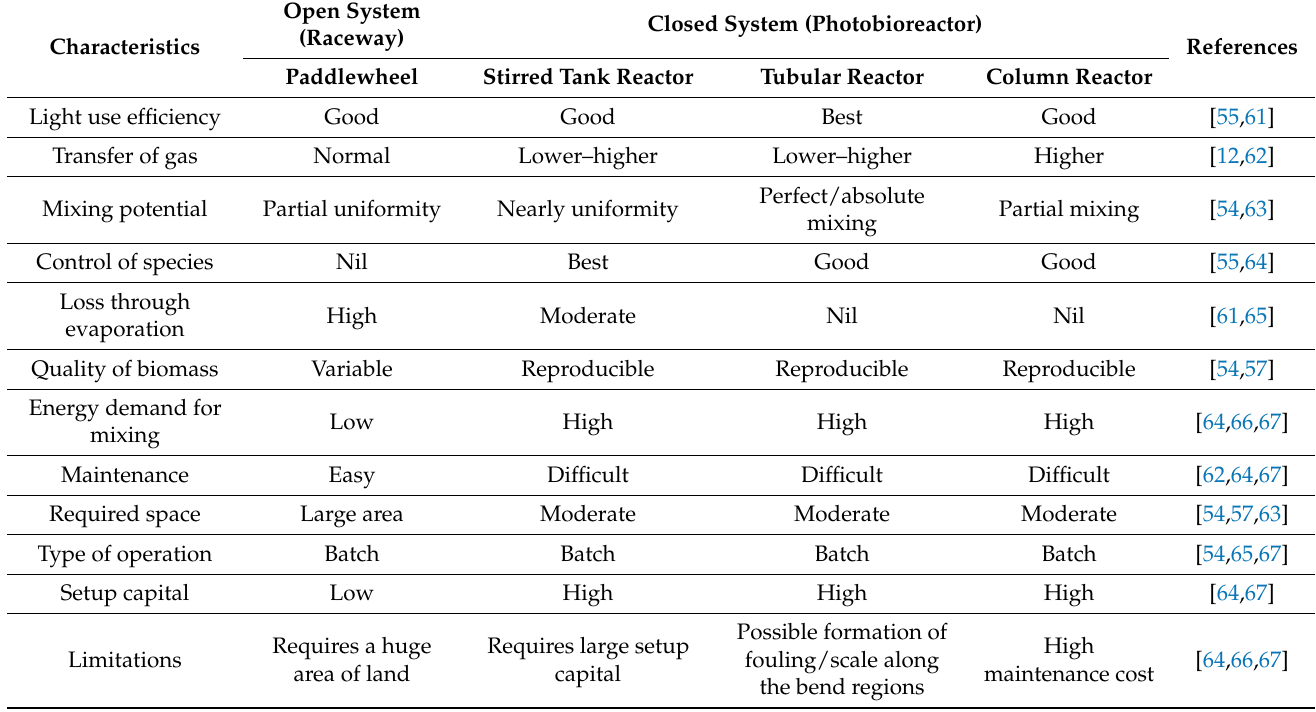
Table 4. The comparison of characteristics of the operating system under the open and close method.